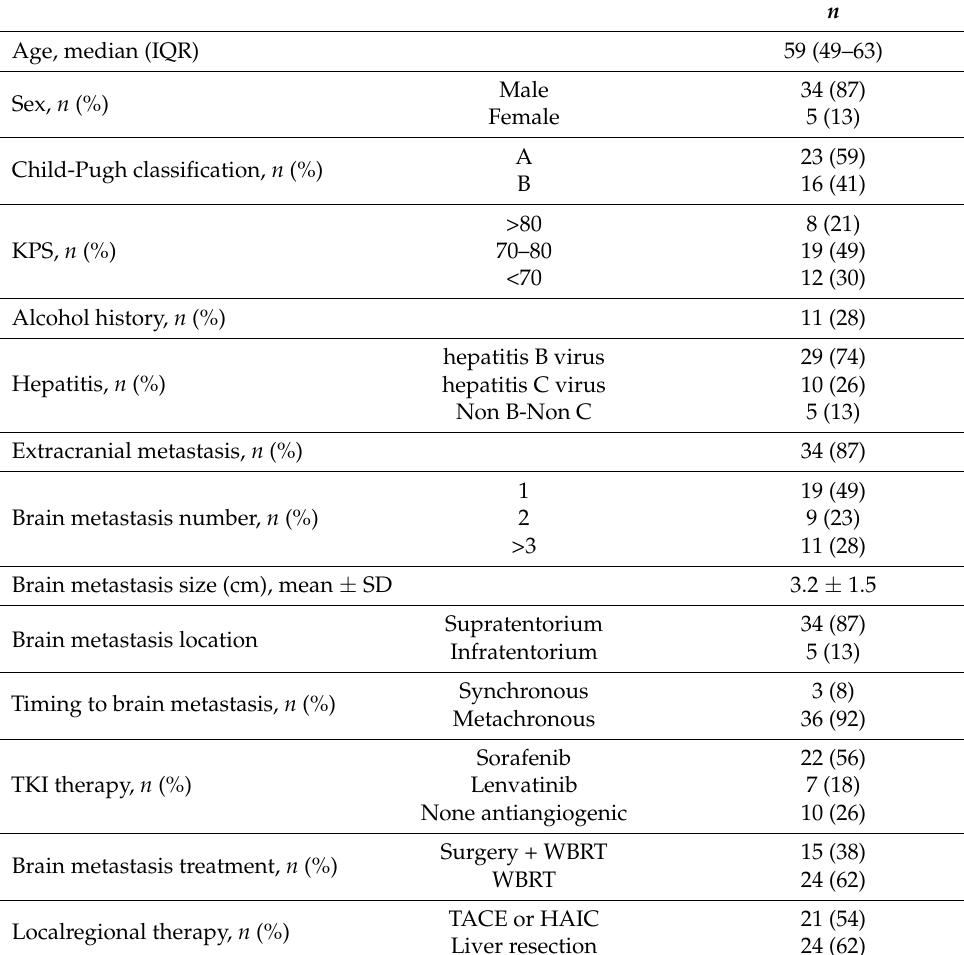
Table 1. General demographic.